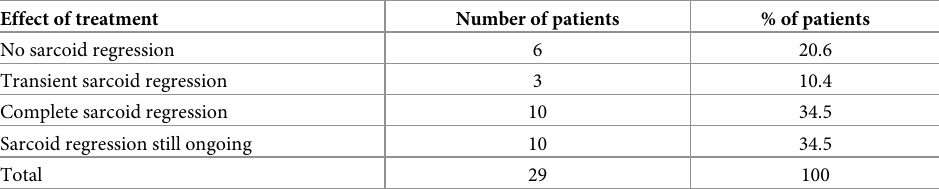
Table 4. Overview on current treatment results (May